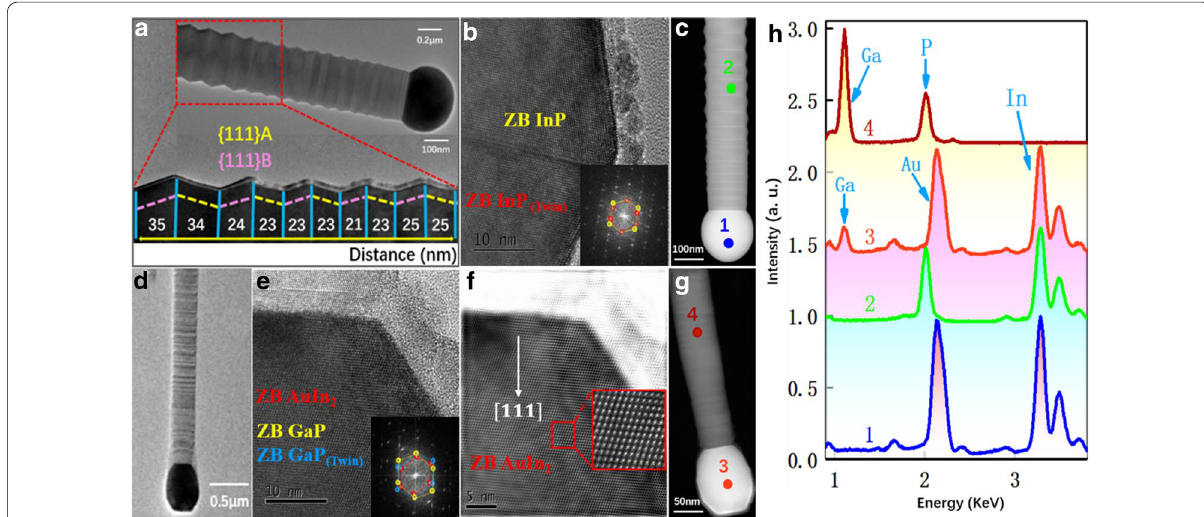
Fig. 4 Structural and composition analysis of InP and GaP nanowires. a , b HRTEM image of an InP nanowire, showing the ZB twinning superlattice structure. d , e TEM images of a GaP nanowire. f Fast Fourier transform image of the Au droplet, demonstrating the formation of AuIn 2 phase. High-angle annular dark-field (HAADF) image of the same InP ( c ) and GaP ( g ) nanowires. h EDX spectra of points 1–4 in ( c , g ). EDX intensity is normalized and shifted for